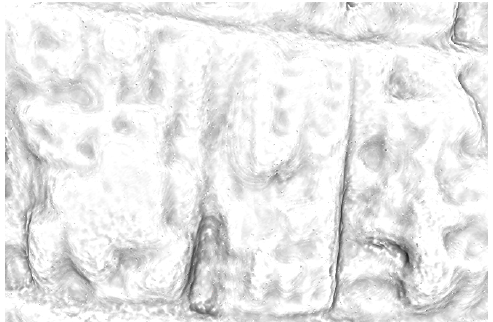
Figure 8: Low mesh resolution of the model of the tablet from Ebla obtained with the 50 mm lens (same detail as Figure 7) However, by means of Maya commercial software (AUTODESK,